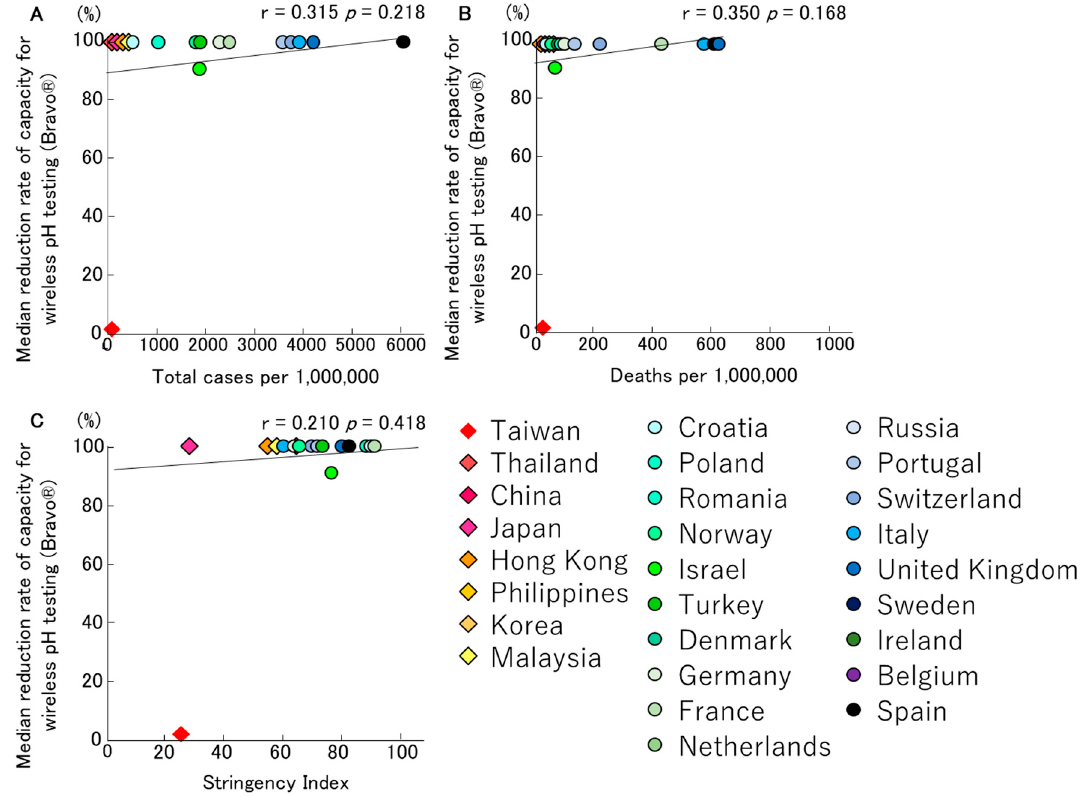
Figure 3. The relationships between median reduction rates of capacity for wireless pH testing (Bravo ® ), total infection rate ( A ) / mortality rate ( B ) for COVID-19 and Stringency Index ( C ) in Asian and European countries, are described. Almost all countries, except Taiwan, had completely discontinued this type of testing.